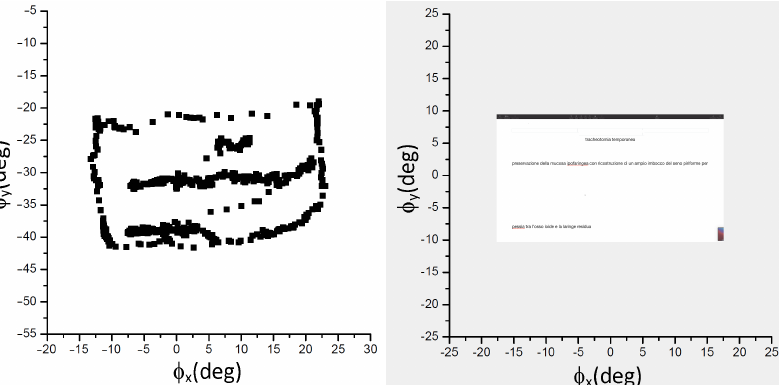
Figure 5. The same data used to produce the gaze trajectories represented in Figure 2 are here elaborated on the basis of the Listing’s model. With an appropriate selection of the ˆ m 0 and ˆ p directions, the whole data set fits with much lower distortion onto a shape that reproduces the text and the monitor frame observed by the subject (sketched in the right figure).